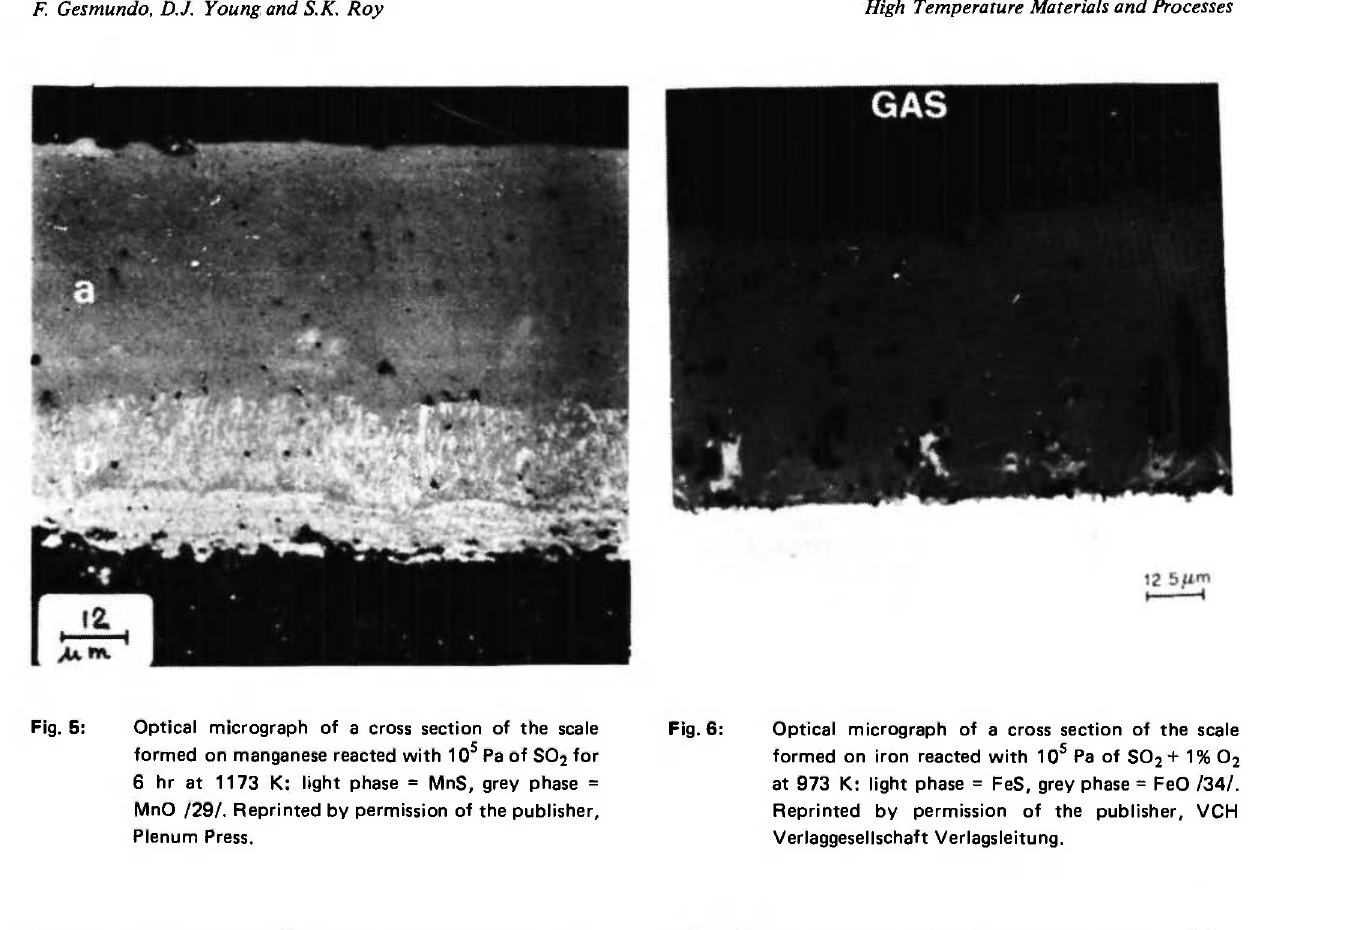
Fig. 6: Optical micrograph of a cross section of the scale formed on iron reacted with 10 s Pa of S 0 2 + 1% 0 2 at 973 K: light phase = FeS, grey phase = FeO /34/. Reprinted by permission of the publisher, V CH Verlaggesellschaft